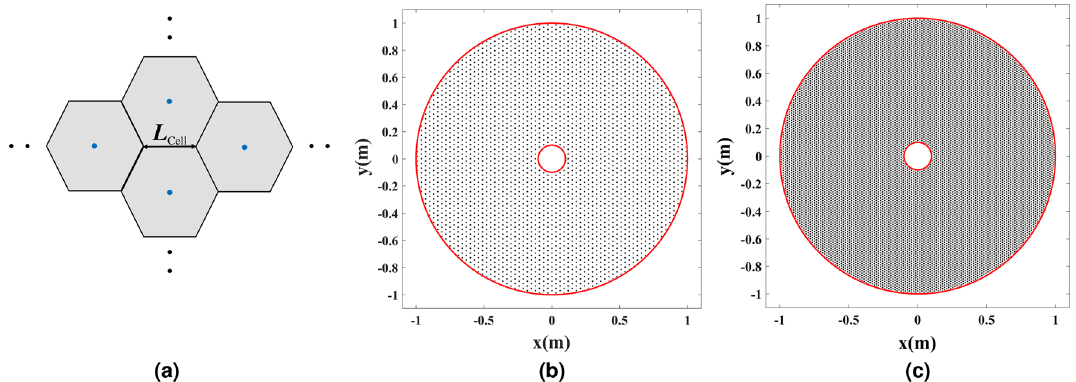
Figure 12. Discretization of refractive index profile in Fig. 9. ( a ) The hexagonal lattice configuration. ( b ) Sampling points for L Cell = (cid:31) / 5 . ( c ) Sampling points for L Cell = (cid:31) / 10 .